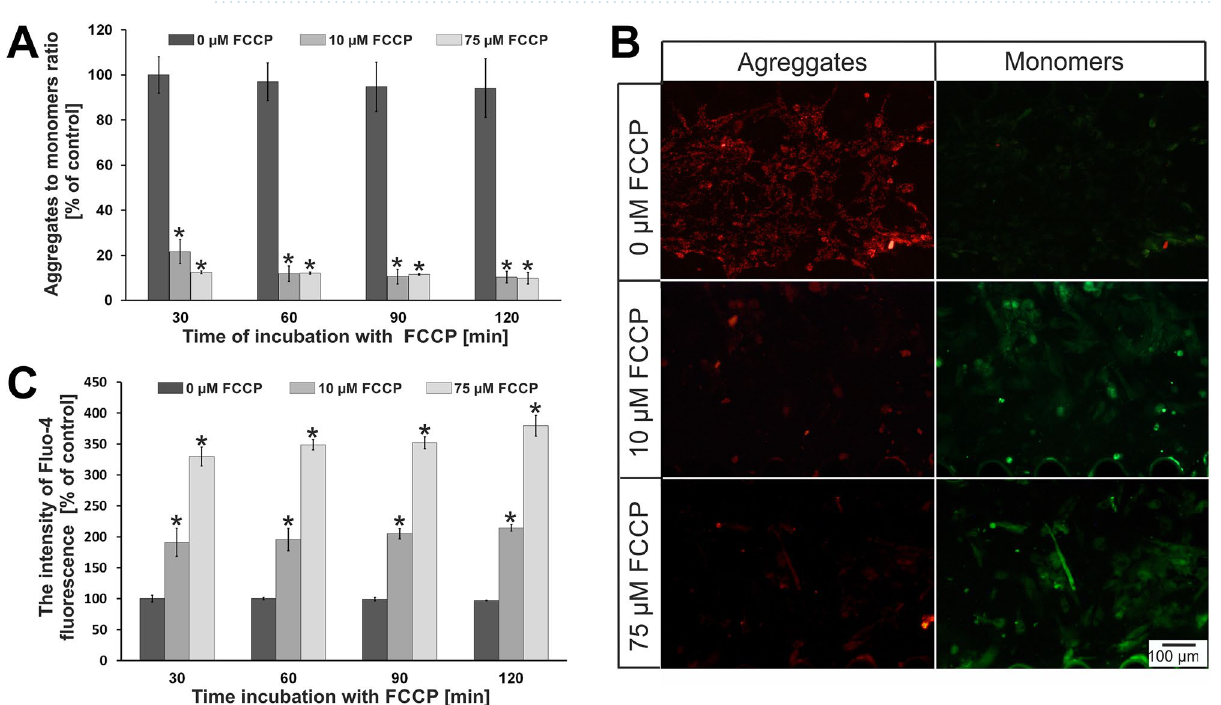
Figure 5. ( A ) The results of changes in mitochondrial membrane potential for HCM cells. N ≥ 3, asterisks indicate p < 0.05. ( B ) HCM cells after 120 min incubation with FCCP. The cells were stained with JC-1. ( C ) The results of changes in concentration of intracellular calcium ions for HCM cells. N ≥ 3, asterisks indicate p <